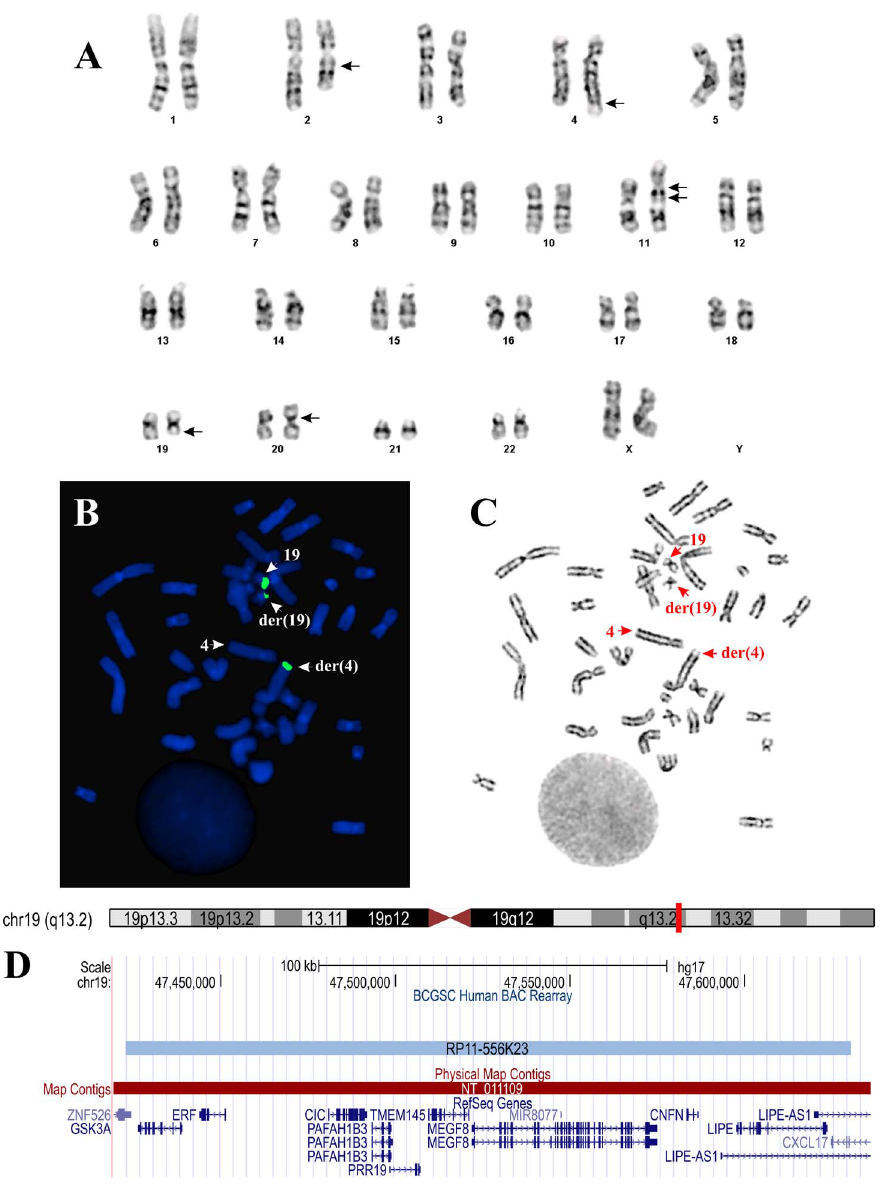
Figure 2. Cytogenetic and FISH analyses of the tumor. A) Karyogram showing chromosome aberrations del(2)(q13q23), t(4;19)(q35;q13), ins(11;?)(q11;?), and der(20)?t(20;20)(p11;q11); breakpoints are indicated by arrows. B) FISH performed on metaphase spread using BAC RP556K23 (green signal) from 19q13 containing the CIC gene. A part from this probe has moved to the derivative chromosome 4. The der(4), der(19), and the normal chromosomes 4 and 19 are indicated by arrows. C) G- banding of the metaphase spread shown in (B). The der(4), der(19) and the normal chromosomes 4 and 19 are indicated by arrows. D) The location of the BAC RP556K23 on chromosome 19 and the genes found in this region. The data obtained from UCSC Genome Browser